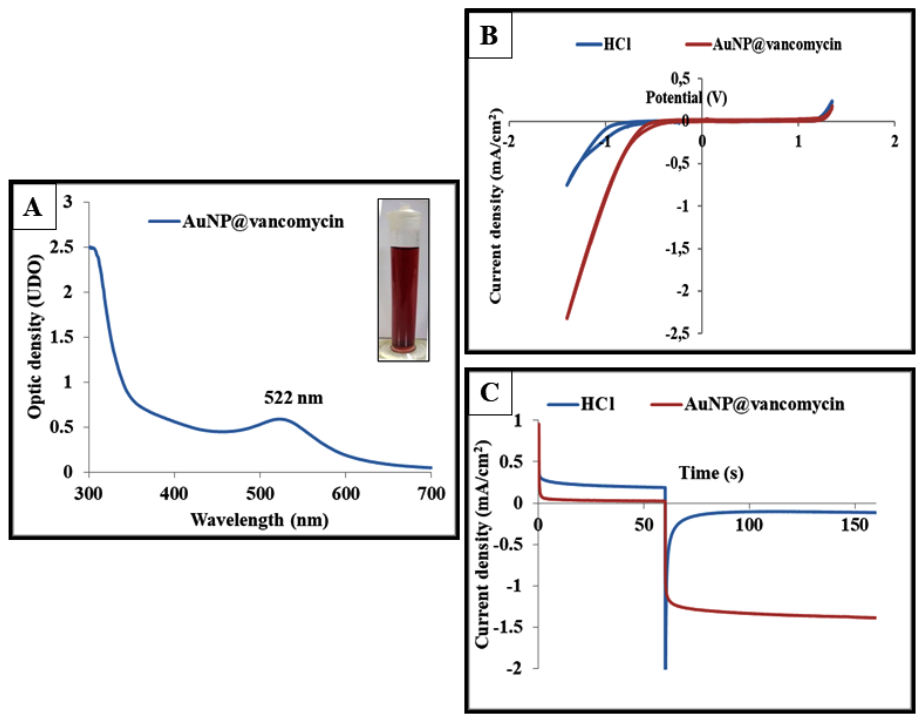
Figure 3. UV–visible absorption spectra and photographs of the vancomycin-coated gold nanoparticles ( A ). Cyclic voltammetry curves recorded between +1.35 V and − 1.40 V at a scan rate of 50 mV/s for a 1 M HCl solution in the absence and in the presence of AuNP@vancomycin ( B ). Chronoamperograms were recorded by applying a potential of +1.35 V for 60 s, followed by − 1.00 V for 100 s, in 1 M HCl solution without (upper curve) and in the presence (lower curve) of AuNP@vancomycin at the surface of a screen-printed carbon electrode ( C